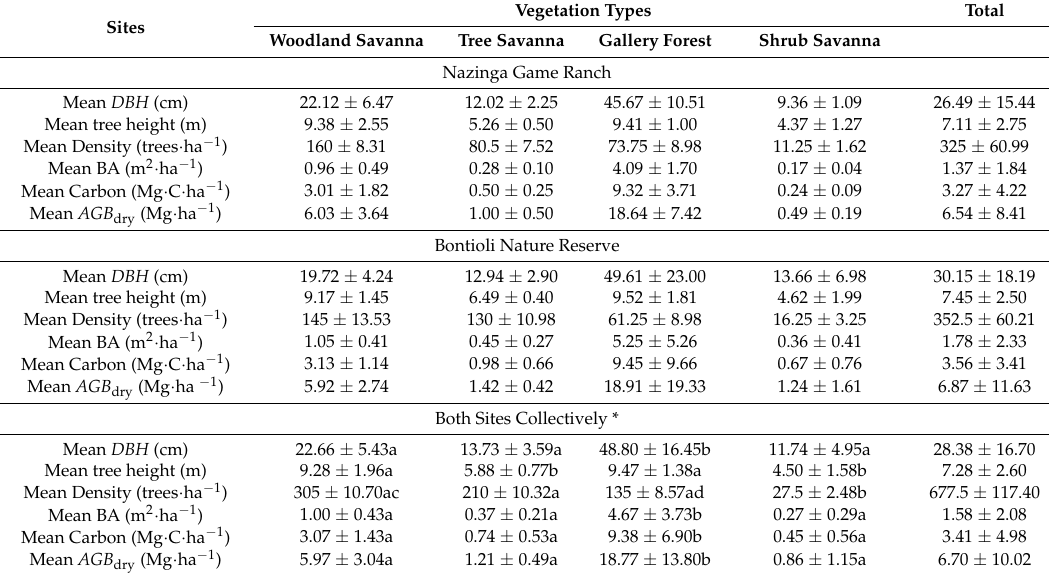
Table 1. Structural characteristics of the four vegetation types at the study sites of Nazinga Game Ranch and Bontioli Nature